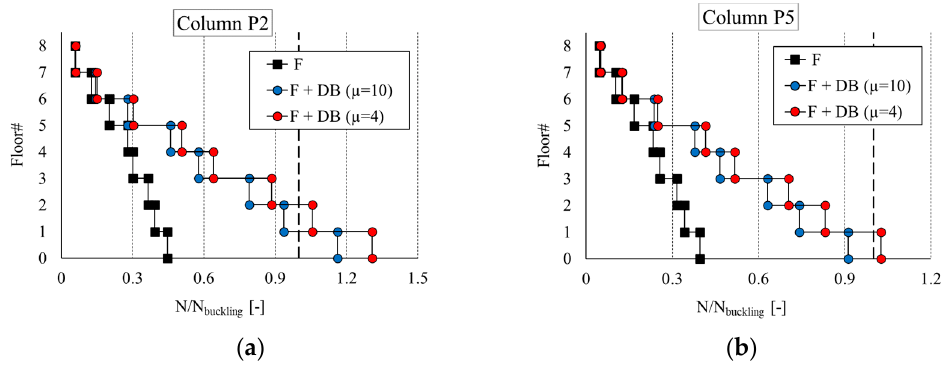
Figure 15. Buckling checks in the most stressed columns in the eight-story MRF: ( a ) column P2 and ( b ) column P5.